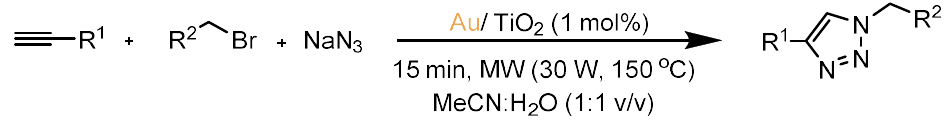
Table 4. Cycloaddition reaction of azides and alkynes catalyzed by Au/TiO 2 a